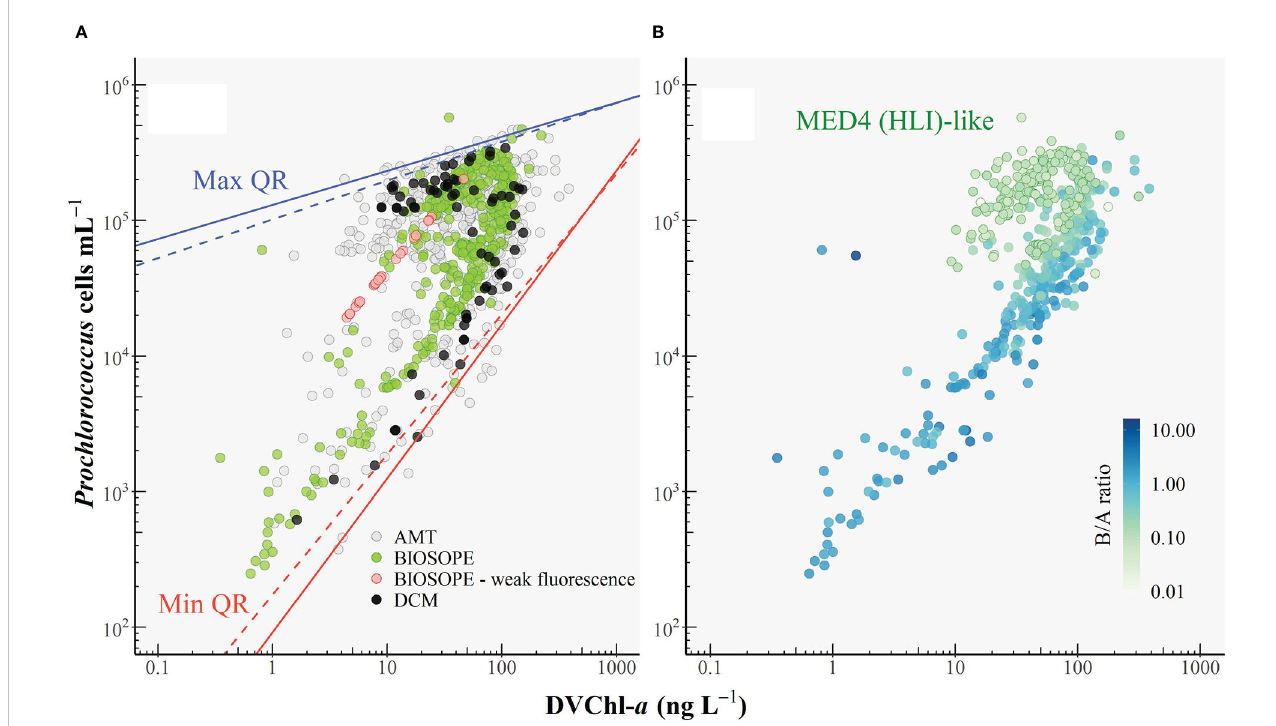
FIGURE 7 (A) Relationship between Prochlorococcus cell abundance and the concentration of divinyl chlorophyll- a (DVChl- a ). The black line represents the line of best fi t, and the grey shaded area indicates the 95% con fi dence interval. The upper (solid blue line) and lower (solid red line) boundaries correspond to the maximum (99th) and minimum (1st) quantiles, respectively. Dashed lines represent the re- fi tted quantile regressions after outliers were removed. Red circles represent the cases where the Prochlorococcus cell number was derived from DVChl- a concentration as the fl uorescence signal measured in fl ow cytometry was too weak. (B) As in Figure 7A with symbols coloured according to the weight-to-weight ratio of divinyl chlorophyll- b to divinyl chlorophyll- a (B/A ratio). Prochlorococcus samples with B/A ratios of<0.14 were classi fi ed as the MED4 (HLI)-like populations. Note that only a subset of the HPLC dataset could be used for this analysis since for some datasets DVChl- b was not separated from monovinyl Chl- b